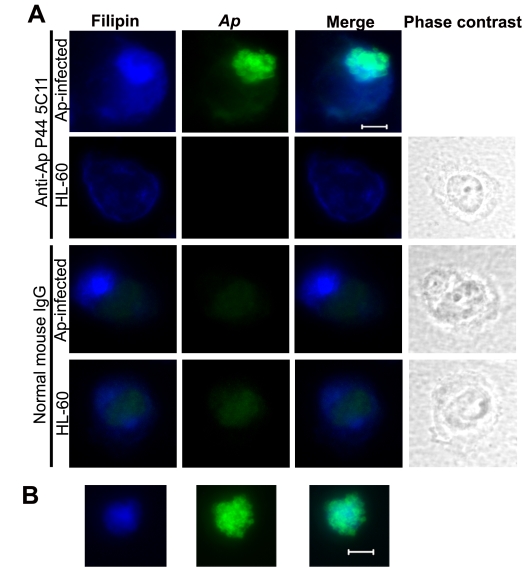
Free cholesterol is enriched in A. phagocytophilum inclusions.
A. phagocytophilum–infected HL-60 cells (A) and A. phagocytophilum inclusions released from host cells (B) were fixed at 2 d p.i., stained with mouse anti-A. phagocytophilum (green) or normal mouse IgG and filipin (blue), and analyzed by fluorescence microscopy. The experiment shown is representative of at least three independent experiments. Bar, 5 µm. Ap, A. phagocytophilum.